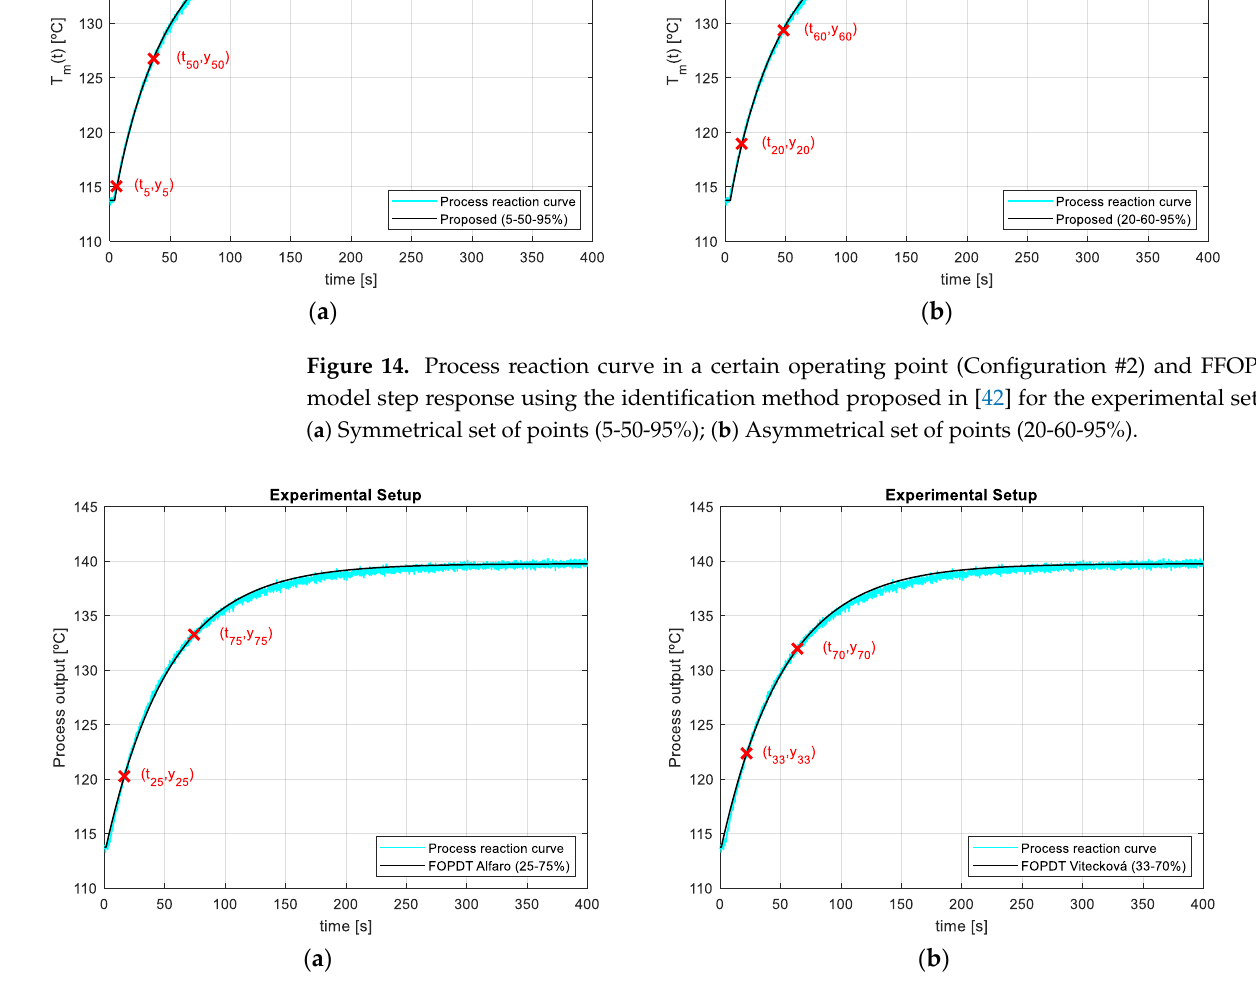
Figure 15. Process reaction curve in a certain operating point (Configuration #2) and FOPDT model step response using two-point identification methods for the experimental setup: ( a ) Method pro- posed by Alfaro in [46]; ( b ) Method proposed by Vitecková in [47].